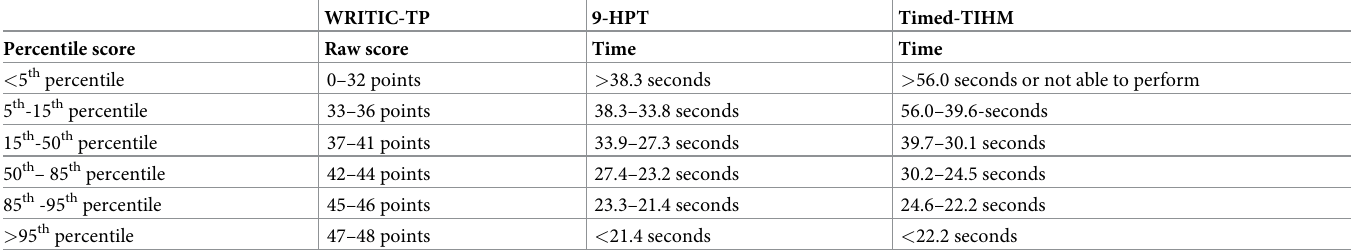
Table 2. Percentile scores of the subdomain ‘task performance’ of the Writing Readiness Inventory Tool In Context (WRITIC-TP), the Nine-Hole Peg Test (9-HTP) and the Timed Test of In-Hand Manipulation